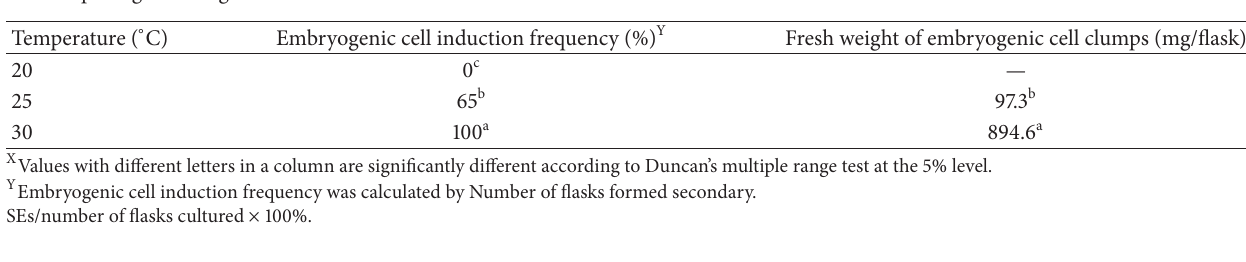
Table 3: Effect of temperature on induction of embryogenic cells from germinated SEs of H. dulcis after 6-week culture on MS liquid medium without plant growth regulators X